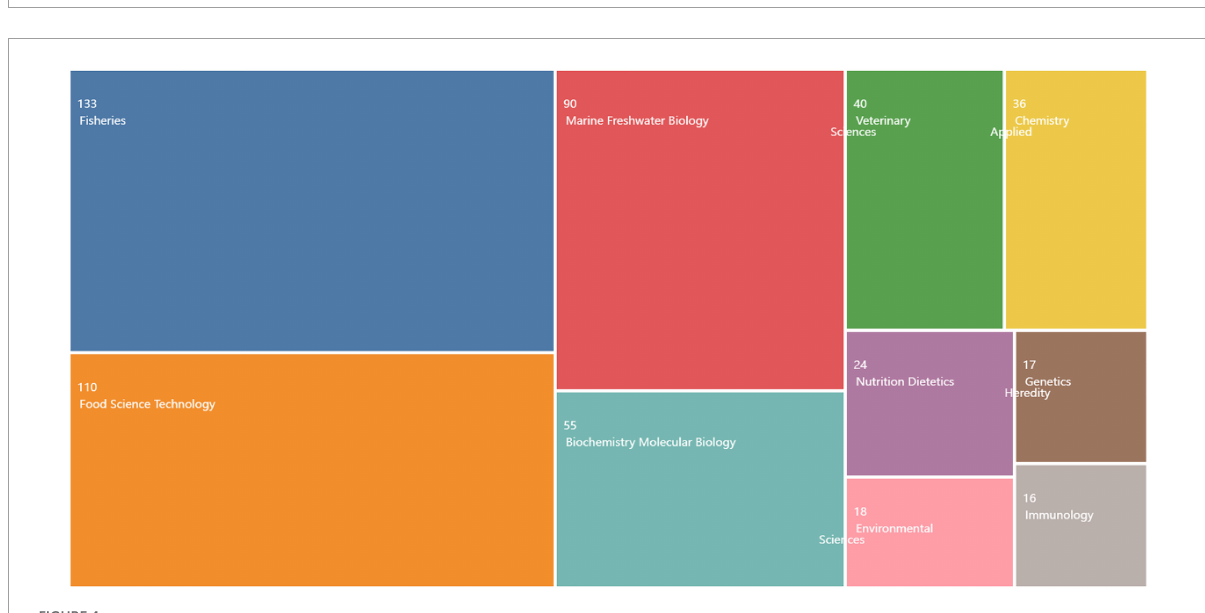
FIGURE4 Global journal of sturgeon deep processing from 2010 to